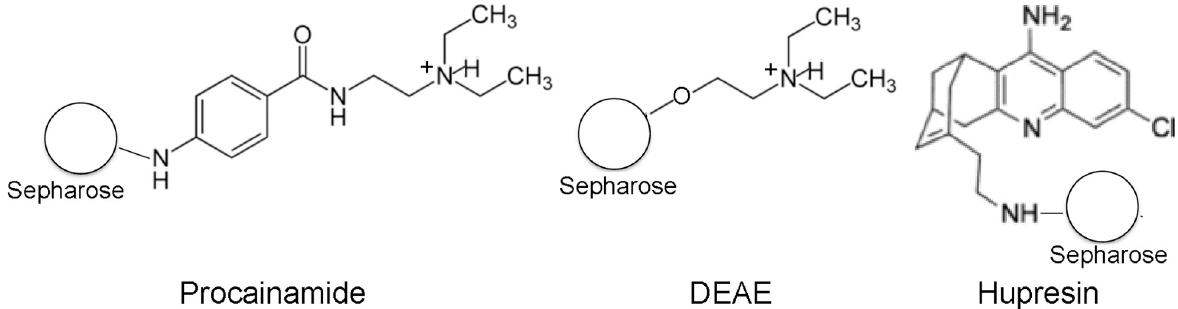
Fig 13. The diethylaminoethyl structure in procainamide is identical to that in the standard DEAE anion exchanger. Hupresin does not have anion exchange properties.